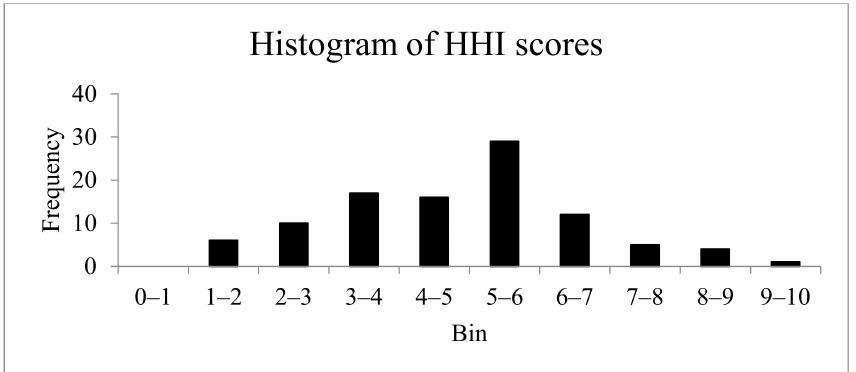
Figure 1. Histogram of the HHI scores showing the highest frequency for 5–6, followed by lower scores. The HHI scores >=7.0 which indicate the high level of consistency are at least represented.